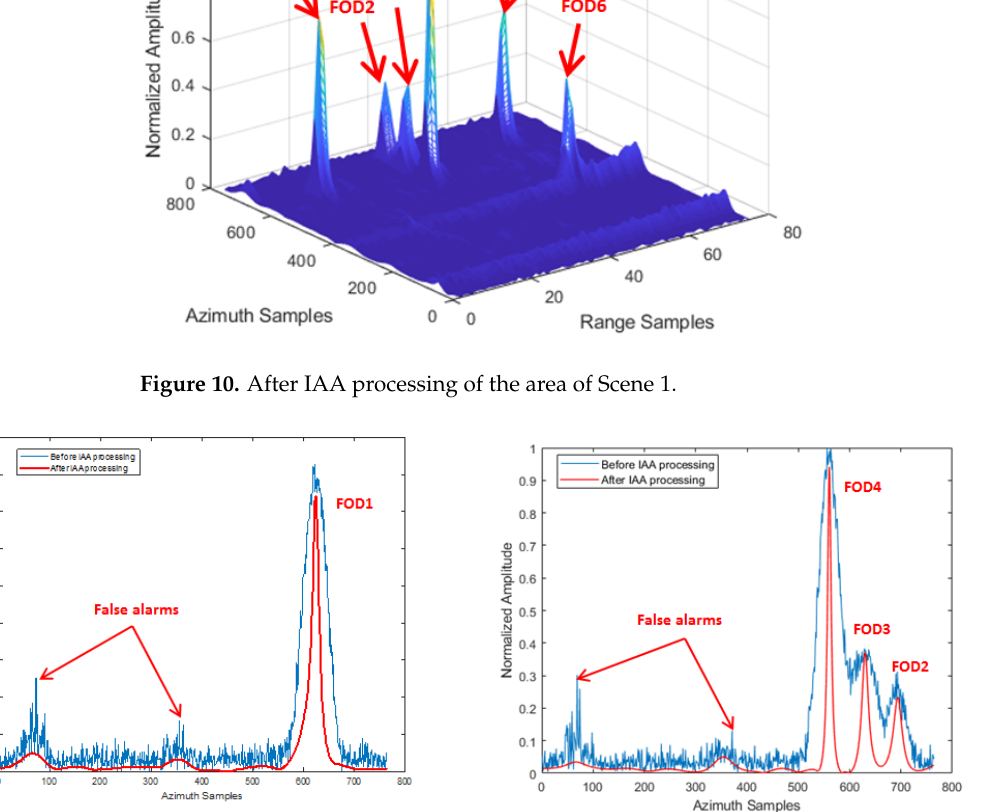
Figure 11. Comparison of IAA processing results for the same range bin: ( a ) before and after IAA processing of azimuth data on the 14th range bin of Scene 1; ( b ) before and after IAA processing of azimuth data on the 37th range bin of Scene 1.